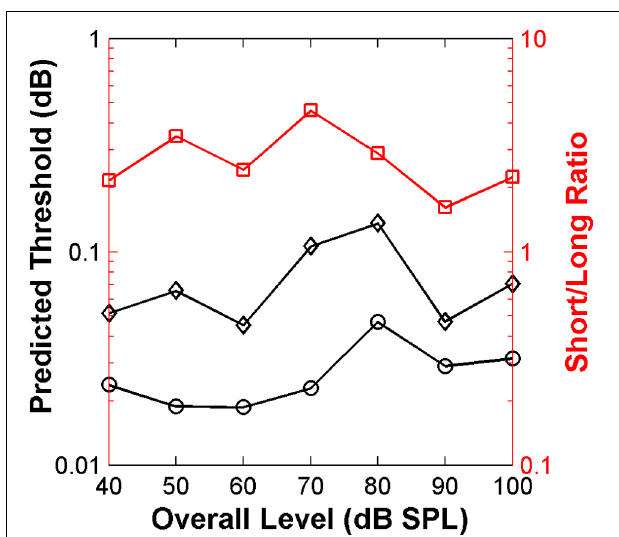
FIGURE 9 | Auditory nerve data: threshold notch depth vs . level functions predicted by an “ideal-observer” analysis of neural responses for noise bursts with different duration: 20ms (diamonds) and 110ms (circles). Red squares (right ordinate axis) illustrate the ratio between predicted thresholds for the long and short